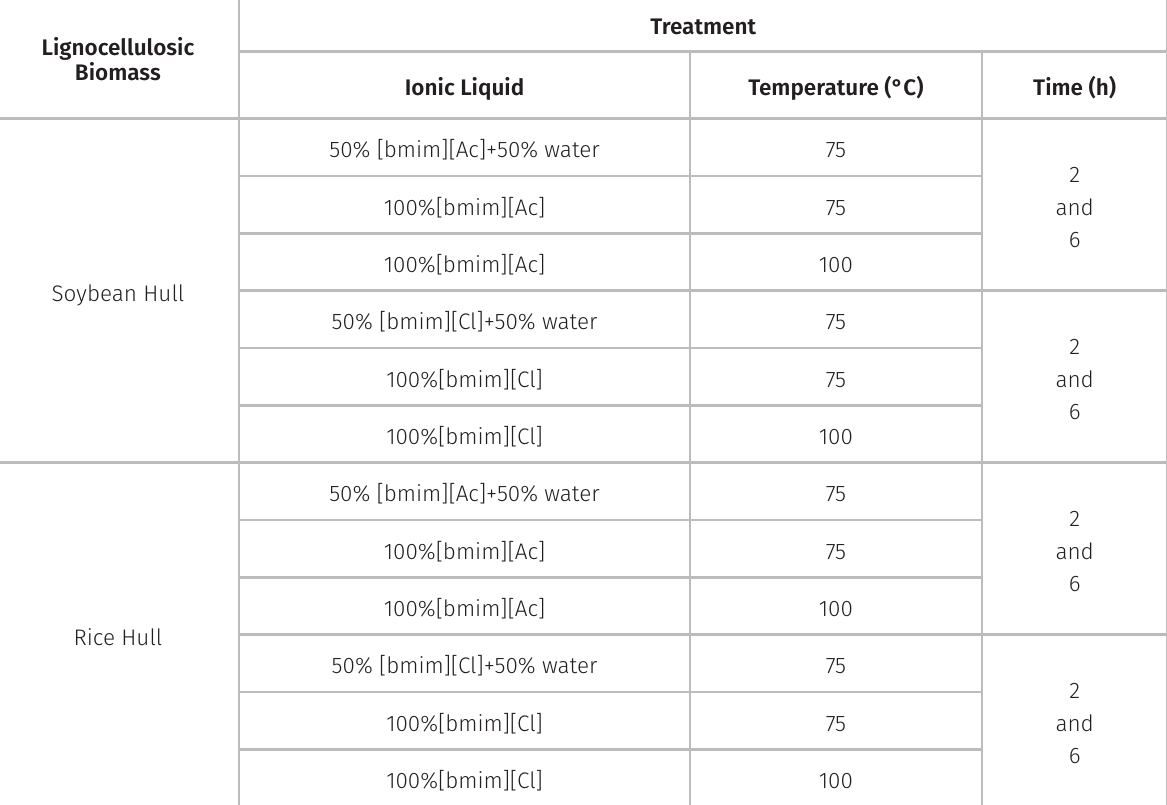
Table I. Lignocellulosic biomass used in this research and the treatment